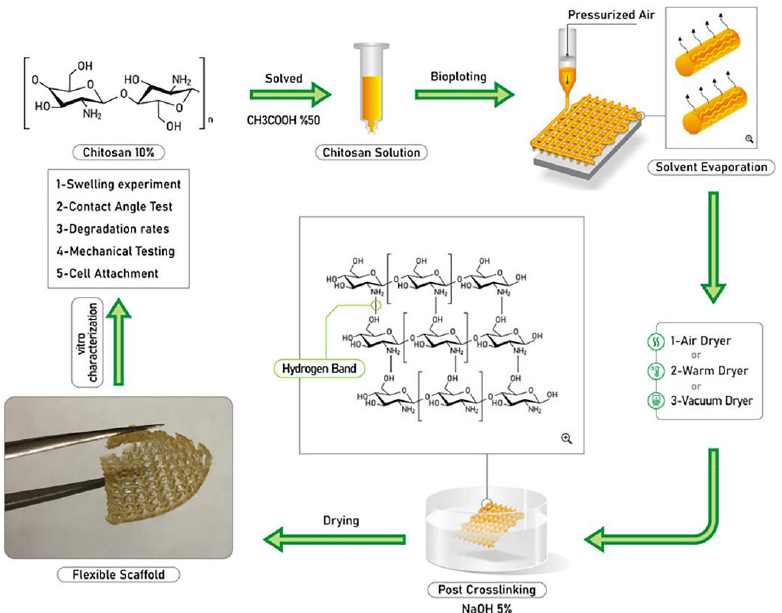
Figure 13. Schematic illustration representing stages including solution preparation, fabrication of 3D printed chitosan scaffolds (10% ( w / v ), chemical reaction, solvent evaporation, post crosslinking, and final drying. Reprinted from [41], Copyright 2020, Elsevier.